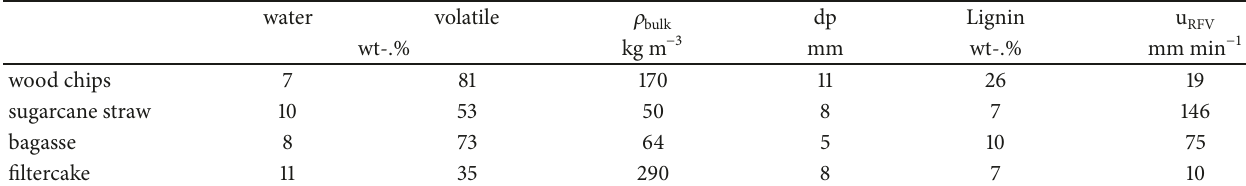
Table 4: Factors influencing the combustion and results of the tests.